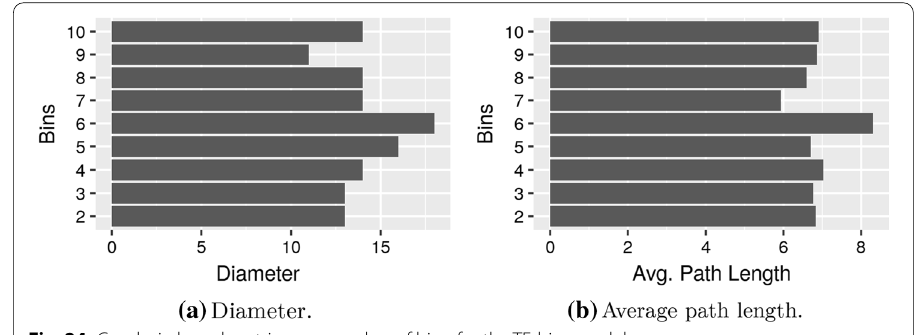
Fig. 24 Geodesic-based metrics, per number of bins, for the TF-bins model